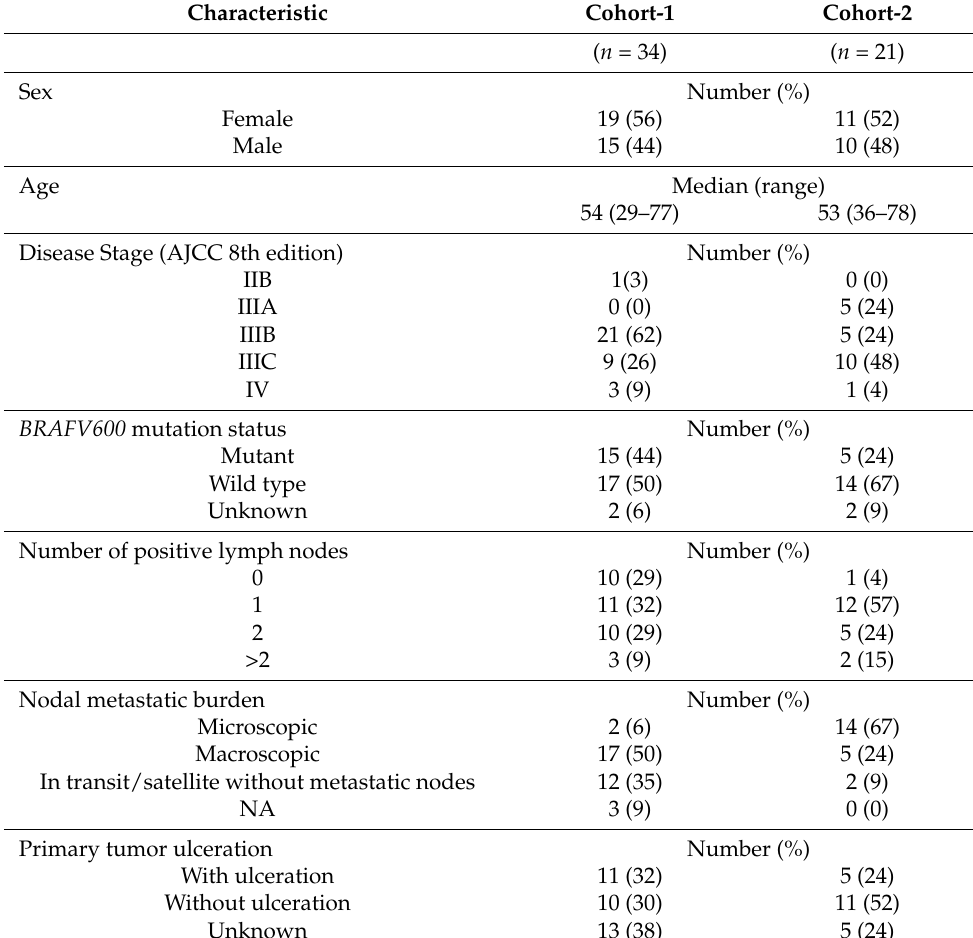
Table 1. Demographic and Clinical Characteristics of the Patients at